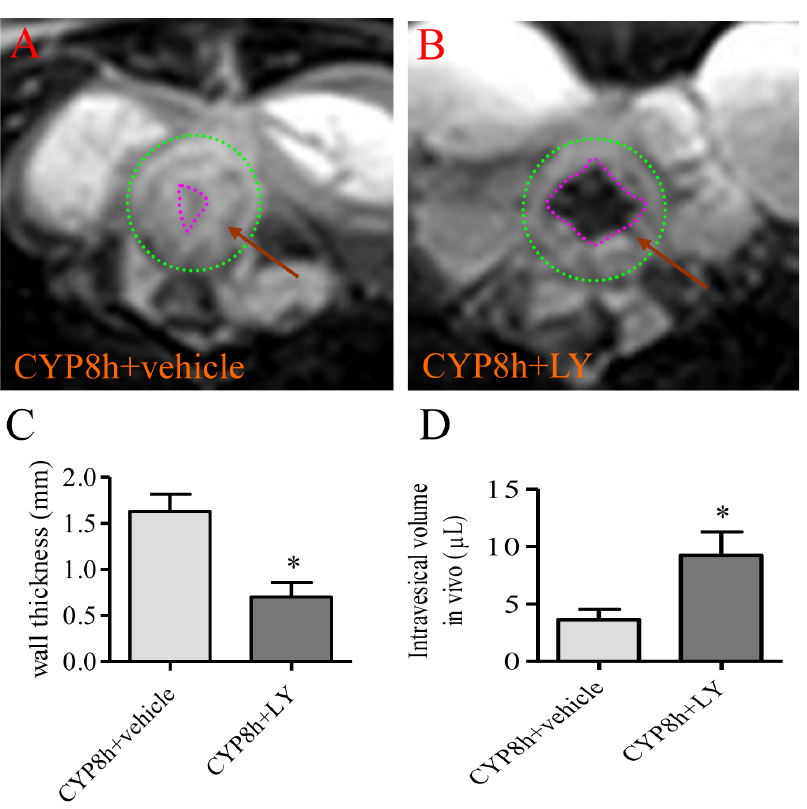
Fig. 2. PI3K inhibition with LY294002 attenuated cystitis-induced bladder wall thickening and restored bladder capacity. The urinary bladders from cystitis animals (8 h, A) and cystitis animals treated with PI3K inhibitor LY294002 (CYP 8 h + LY, B) were visualized by MRI. Green circle indicated the outer edge of the urinary bladder (A, B); the pink circle indicated the inner edge of the urinary bladder (A, B). Treatment with LY294002 prevented bladder wall thickening caused by cystitis (C), and also increased the intravesical volume during cystitis (D). n 5 4. *, p , 0.05.